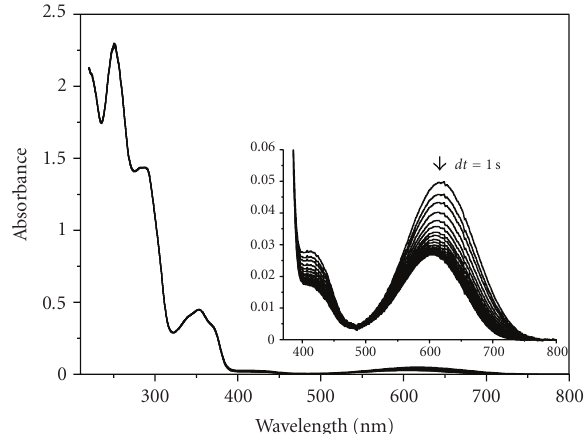
Figure 4: Change in the absorbance spectra of the compound 5a in acetonitrile ( C = 6,43 × 10 − 5 M, T = 30 ◦ C) after irradiation (back thermal reaction).